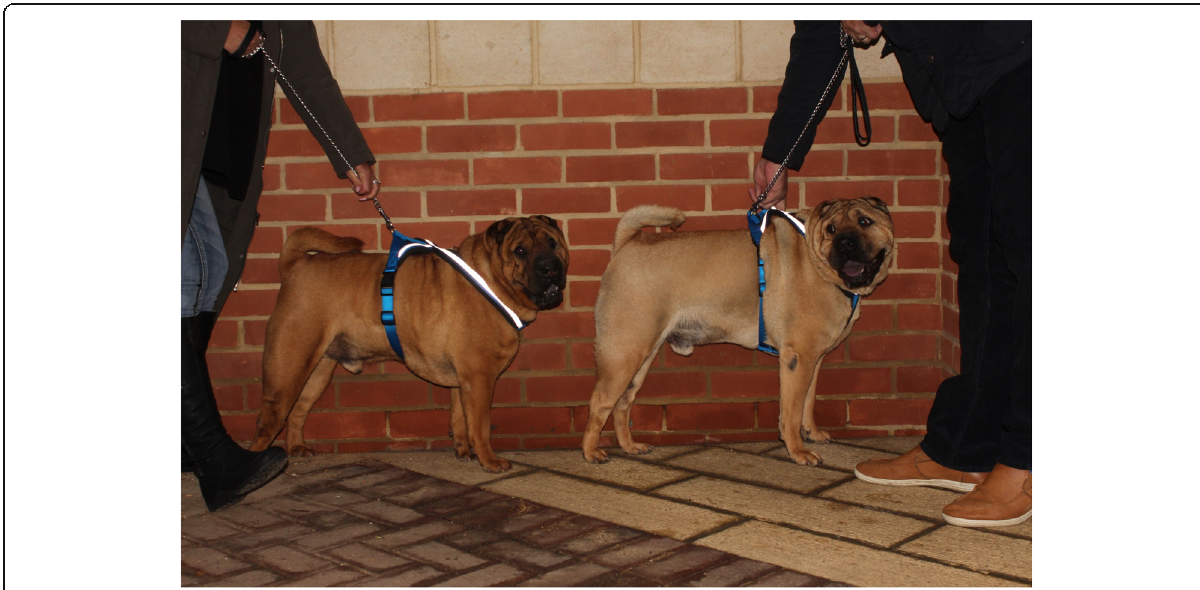
Fig. 3 An example of the height difference between two male SP littermates, affected (left), carrier